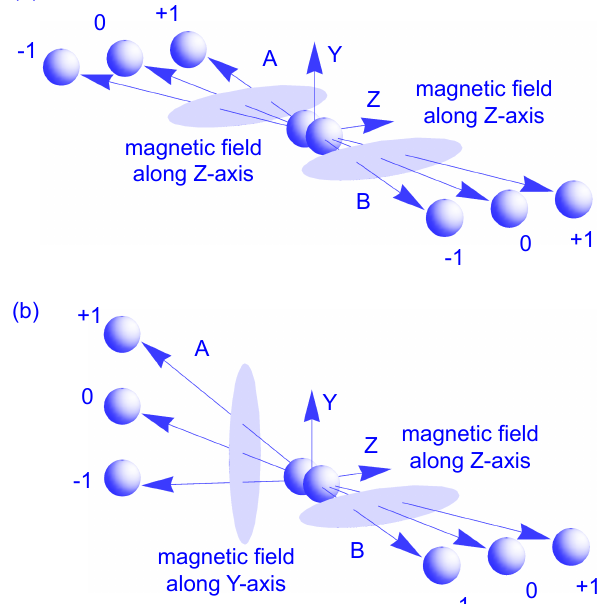
Figure 4: Schematic diagram of a discrete version of Popper’s experiment using entangled spin-1 particles in Stern-Gerlach magnetic fields. (a) The magnetic fields in the paths of particle A and particle B are oriented along the z-axis. (b) The mag- netic field in the path of particle A is oriented along the y axis, whereas the magnetic field in the path of particle B is oriented along the